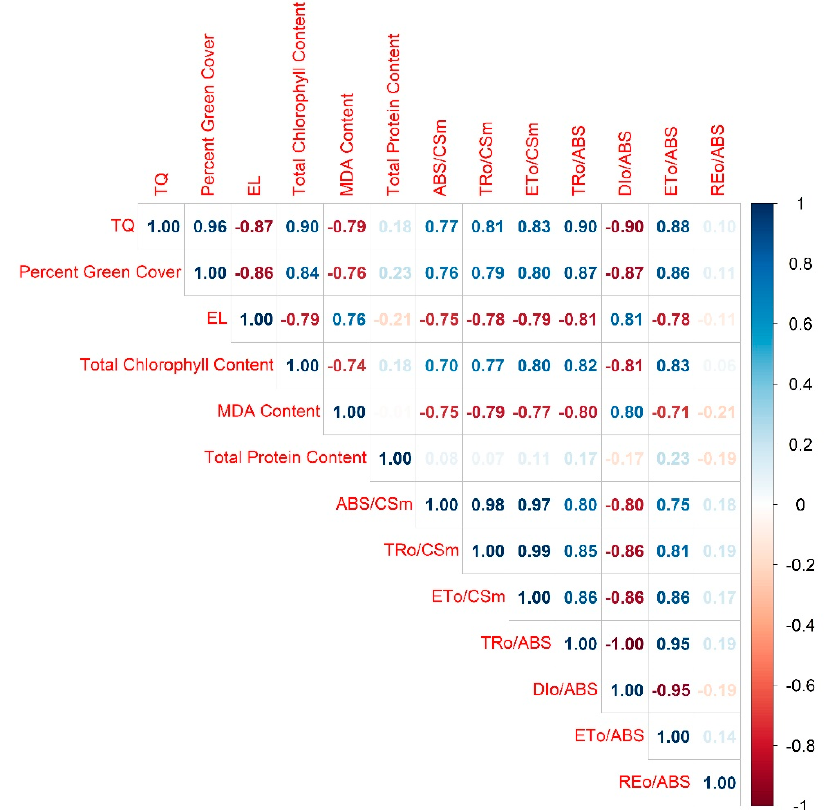
Figure 13. Correlation plot for different parameters of creeping bentgrass under control (20/15 °C day/night) and heat stress (38/33 °C day/night) conditions. Numbers indicate correlation coefficients. Color intensity is proportional to the correlation coefficients with blue indicating positive correlations and red representing negative correlations. Correlation coefficient values were left blank when not significant at p = 0.05.